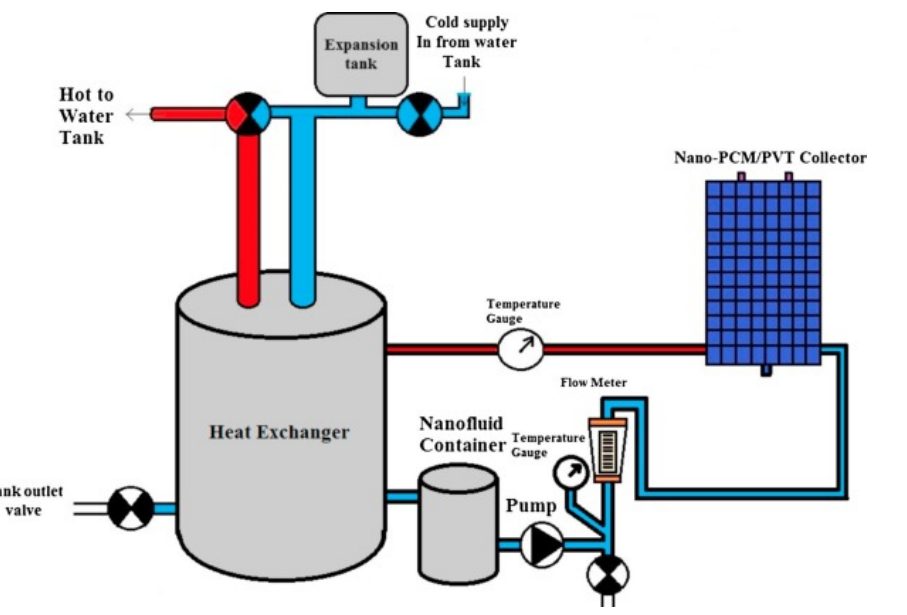
Figure 53. Schematic diagram of an experimental setup for a hybrid cooling system [203]. Table 9. Summary of different cooling techniques noted in the literature.